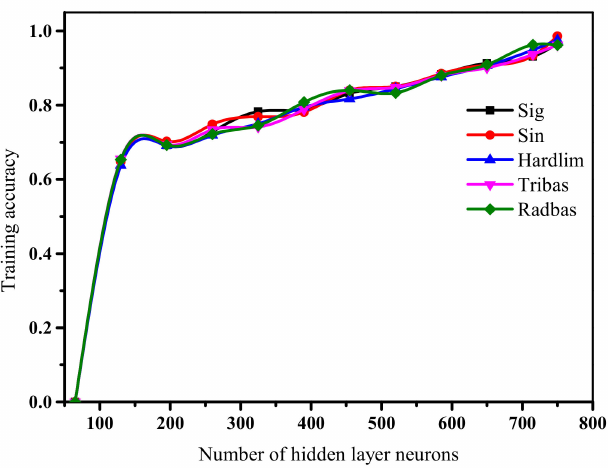
Figure 7. Relationship between activation function, number of hidden layer neurons, and training